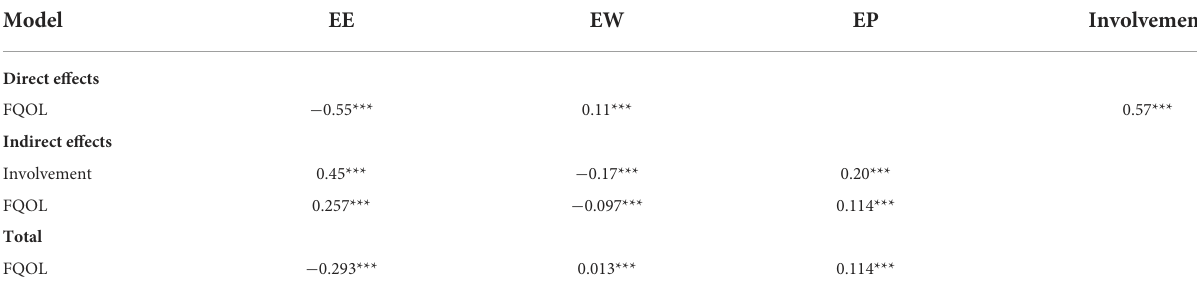
TABLE 3 Results of structural equation model